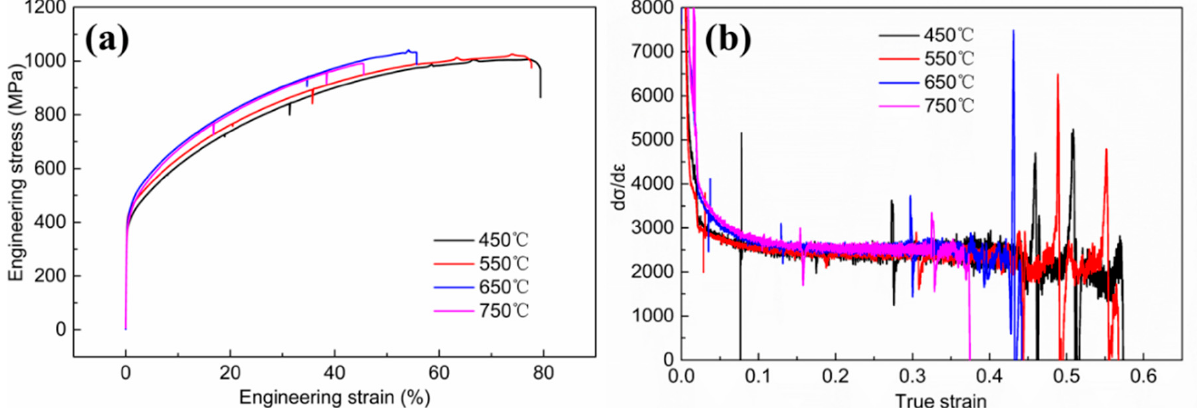
Figure 5. Mechanical properties of the tested alloy demonstrated in terms of the engineering stress–strain curve ( a ) and the corresponding work hardening curve with respect to true strain ( b ).